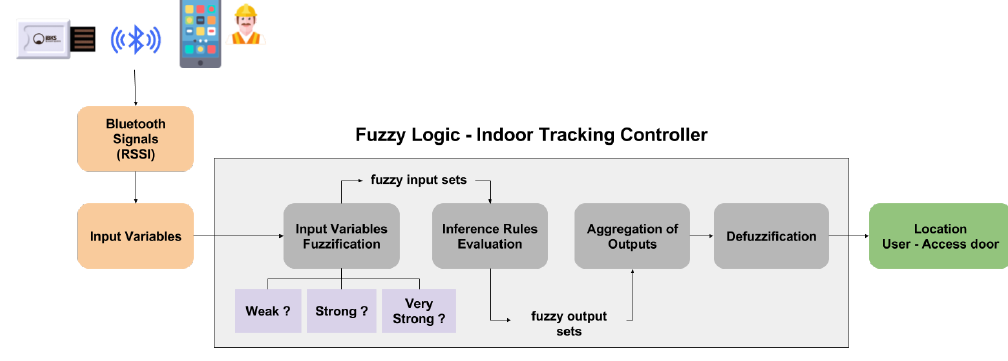
Figure 2. Fuzzy Indoor Tracking